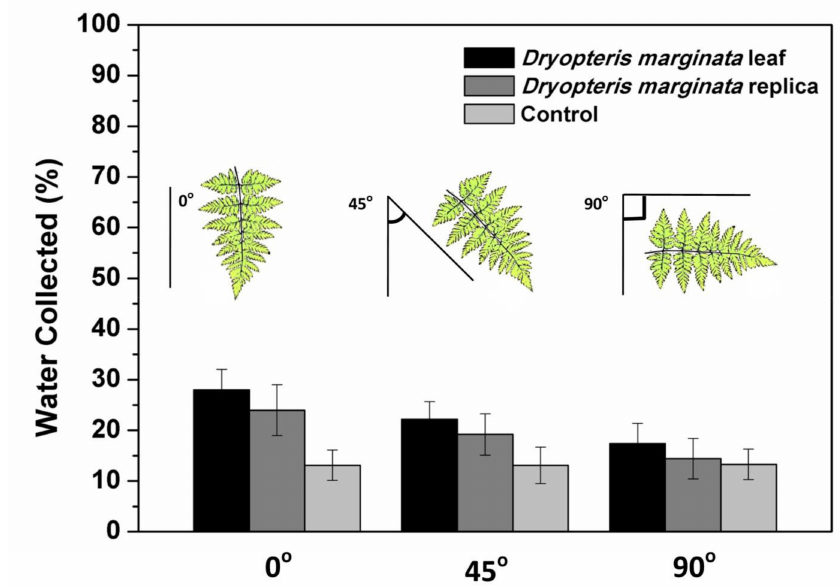
Figure 7. Water collection efficiency of the D. marginata leaf surface, its replica, and the control sample at different angles. Data is shown as the mean ± standard